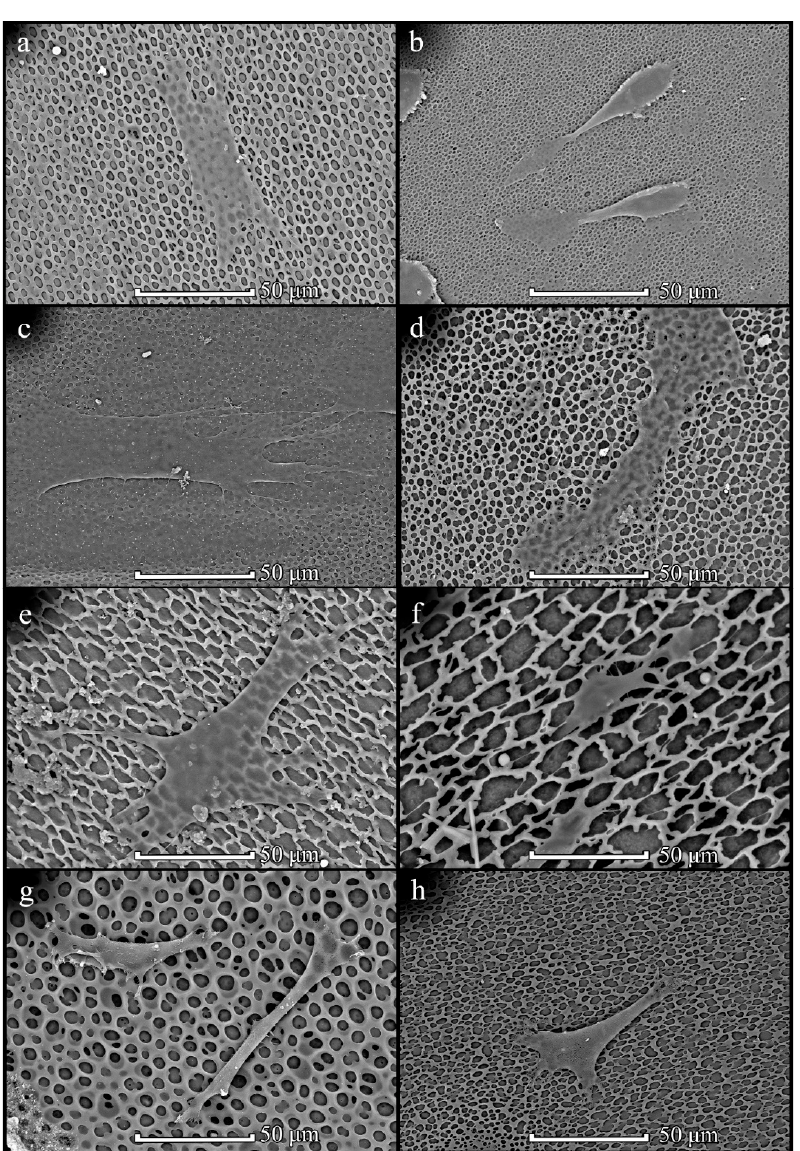
Figure 13. SEM images of MSCs on films: PHB350 1 cm 20 mg/mL 150 μ L ( a ), PHB350 1 cm